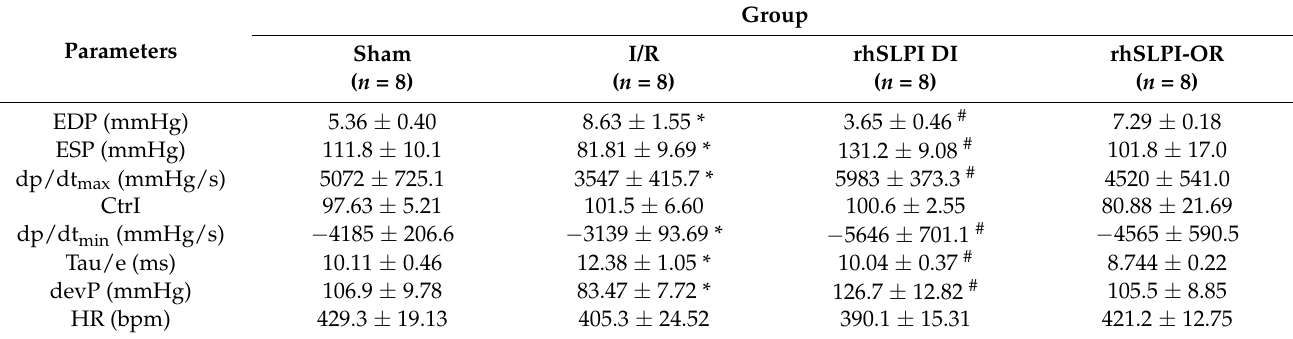
Table 2. The parameters of left ventricular pressure of ischemic phase determined the effect of rhSLPI on LVP parameters in MI (30 min after ligation).